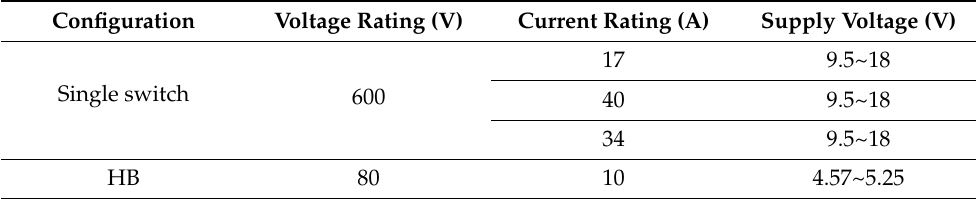
Table 27. Commercial switch-driver-integrated module by Texas Instruments.